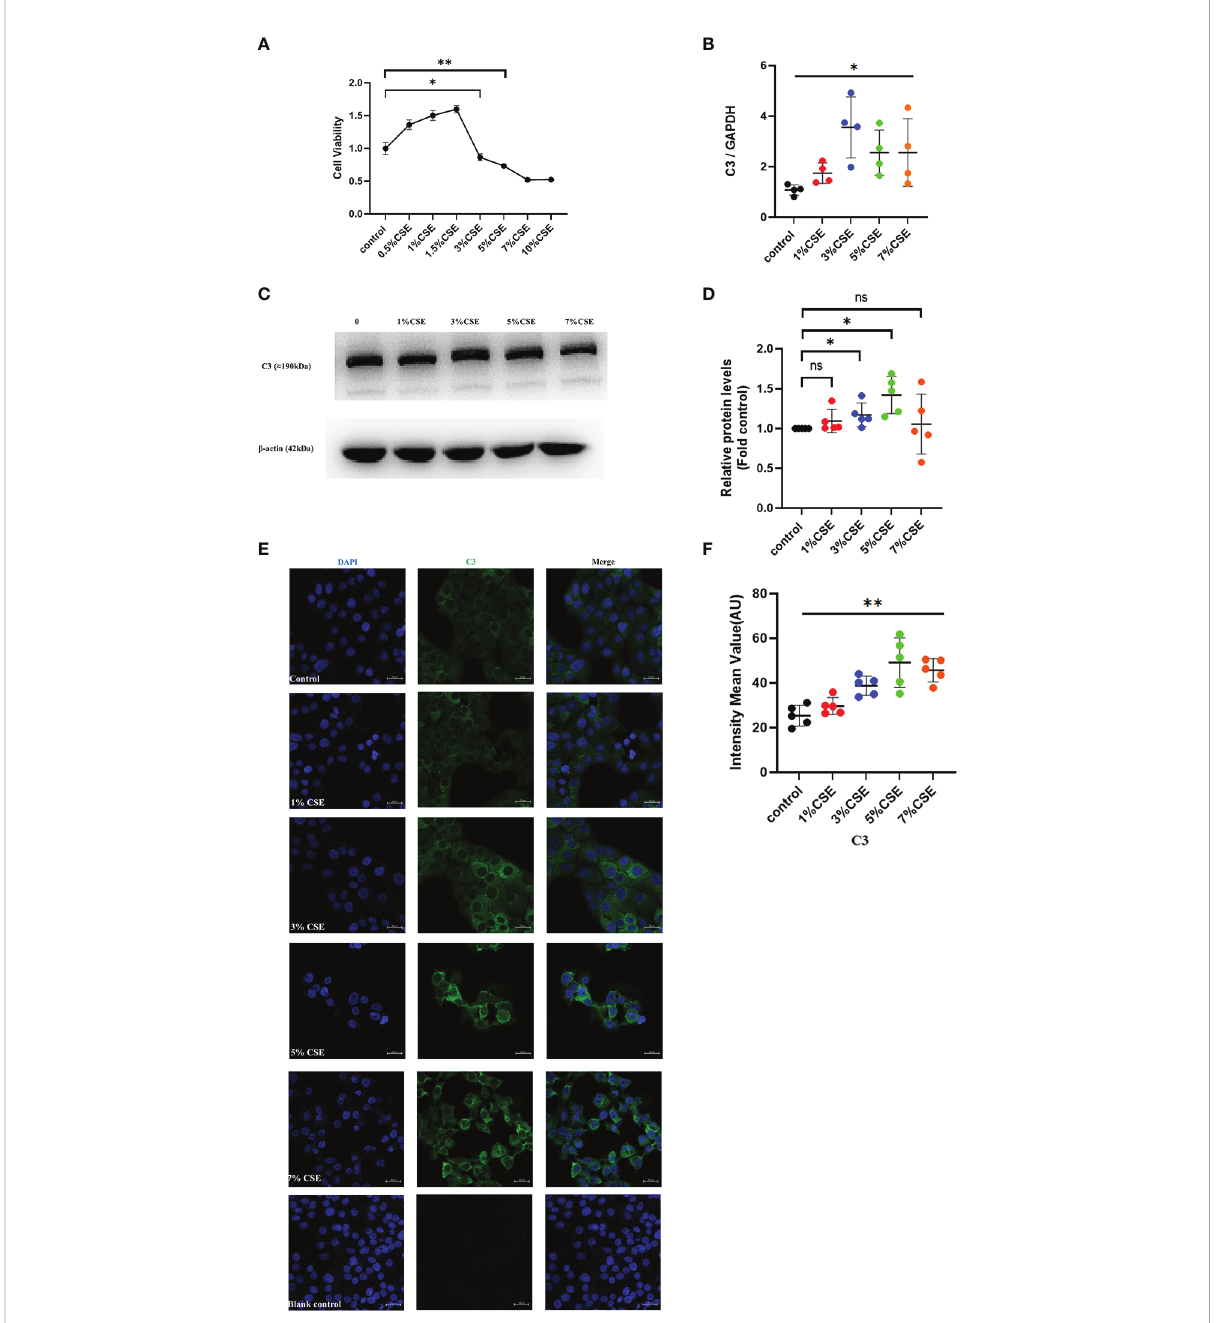
FIGURE 3 CSE promoted the expression of C3 in lung AECs. (A) 16HBE cells were treated with CSE for 24 h, and cellular viability was assessed by CCK8. * P < 0.05. (B, C) After 16HBE cells were treated with CSE (1%, 3%, 5%, or 7%) for 24 h, the level of C3 in AECs was measured by qRT-PCR and western blot. * P < 0.05. N = 4 independent experiments. (D) Expression of C3 was quanti fi ed in 16HBE cells after incubation with different concentrations of CSE for 24 h. * P < 0.05. N = 5 independent experiments. (E, F) Expression of C3 in 16HBE cells after CSE incubation for 24 h by immunocytochemistry. Bar: 20 m m. **P < 0.01, ns, no signi fi